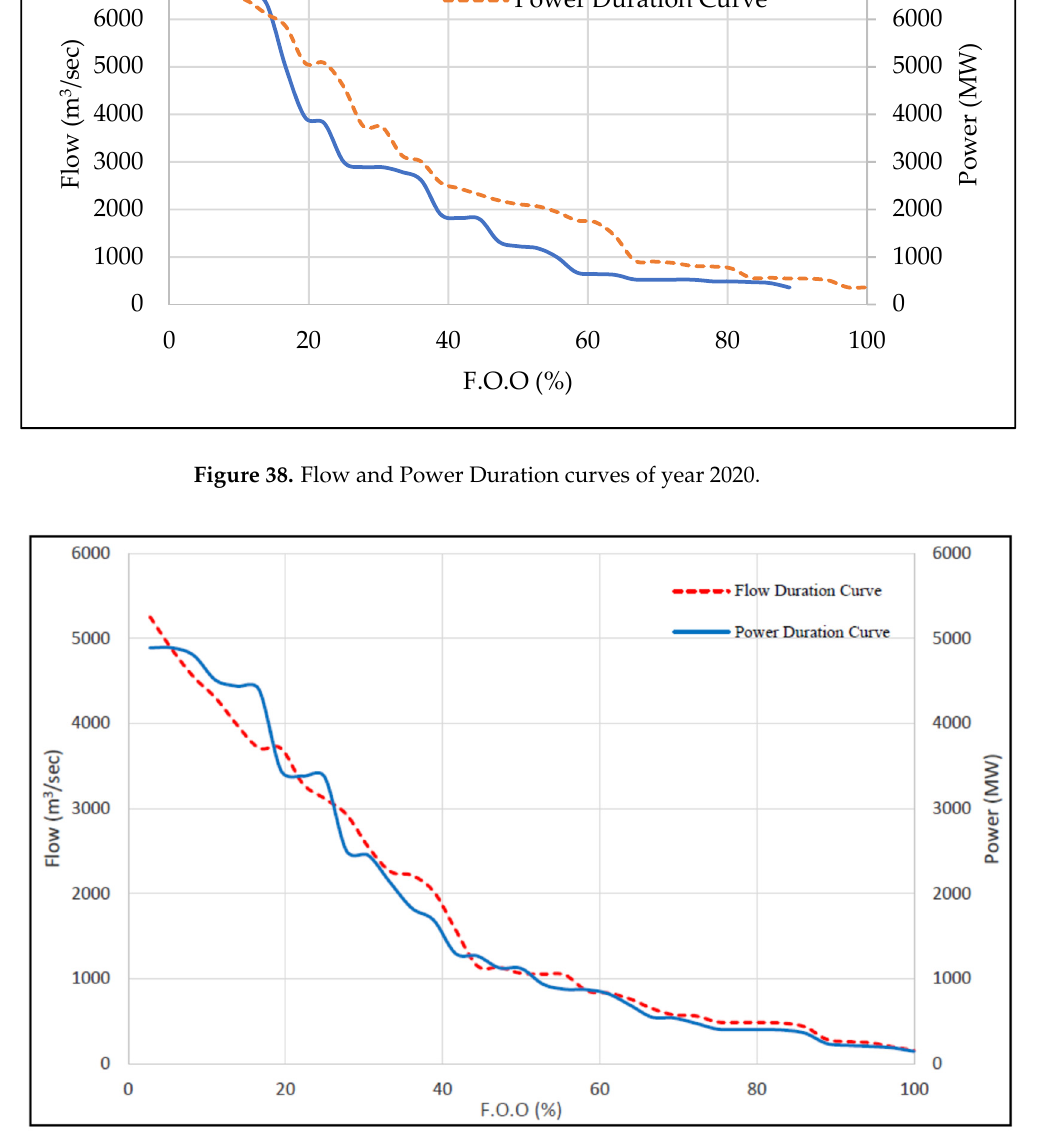
Figure 40. Flow and Power Duration curves of Application year 2030.